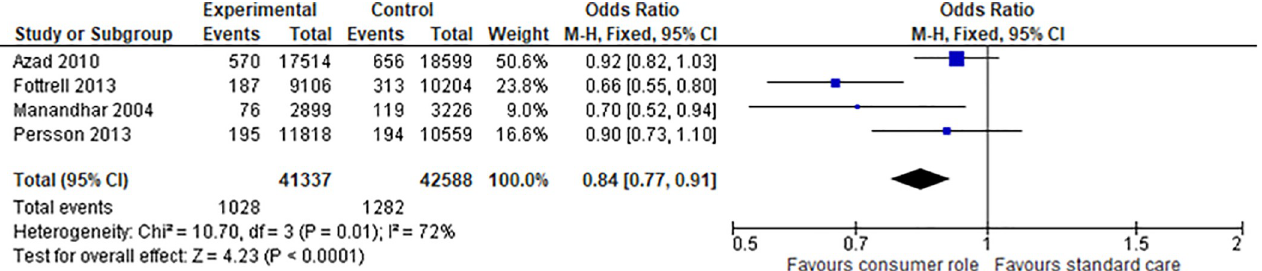
Fig 3. Meta-analysis of consumer engagement interventions for the outcome of neonatal mortality.